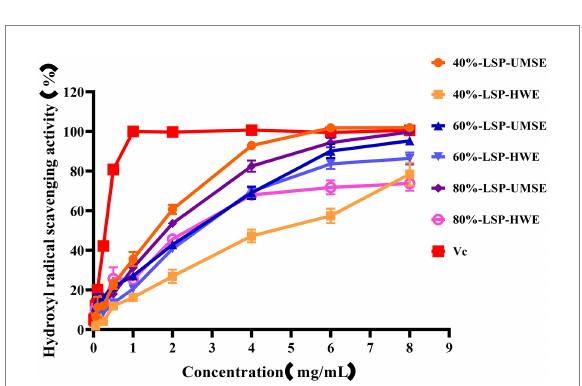
FIGURE 5 Scavenging ability of LSP-UMSE and LSP-HWE on OH scavenging ability. Each value is expressed as mean ± SEM ( n = 3).